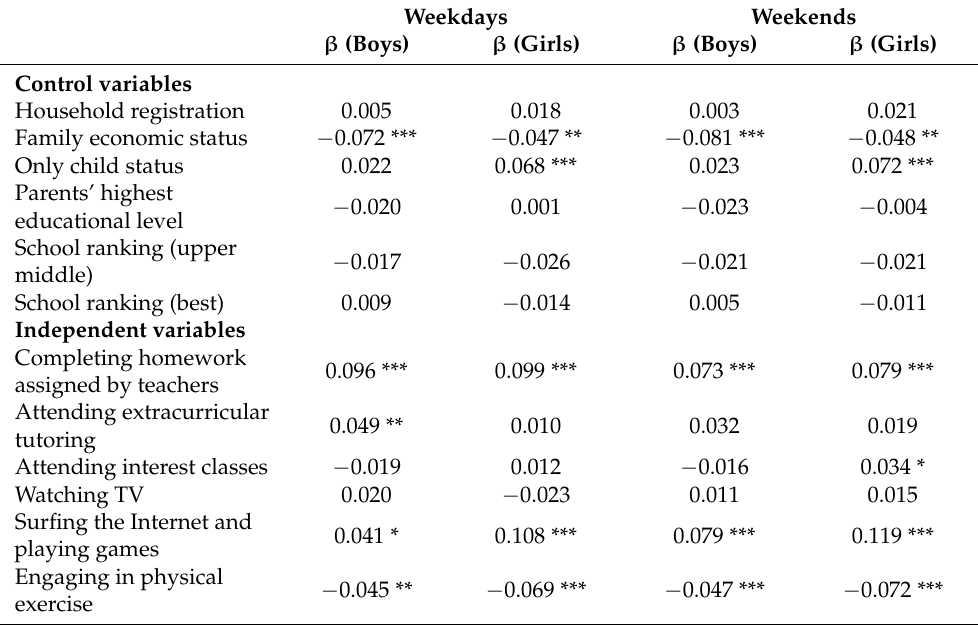
Table 5. Effects of extracurricular activities on depressive symptoms among boys and